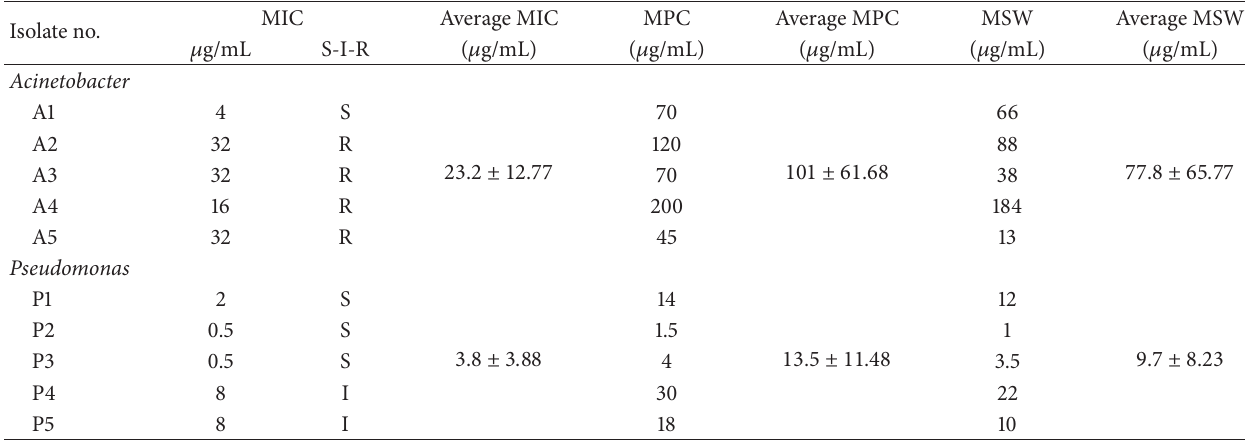
Table 5: Determination of MIC, MPC, and MSW using Meropenem.